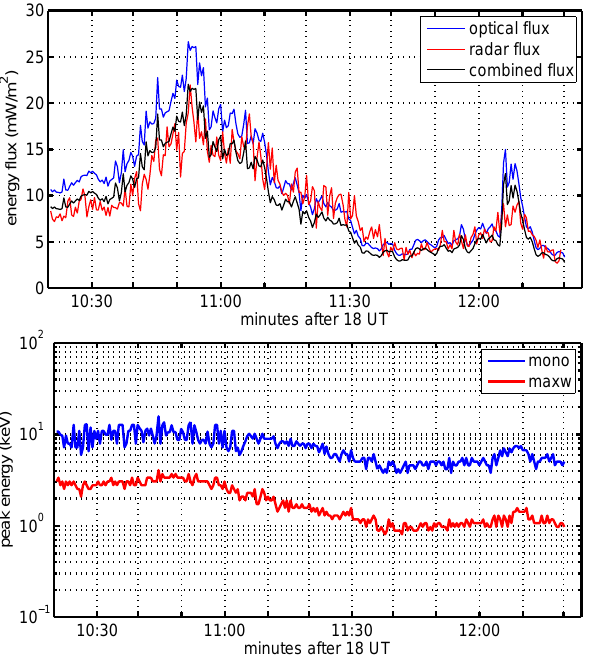
Fig. 5. (a) Total energy flux determined from radar and optical methods. (b) Peak energies of monoenergetic and maxwellian dis- tributions used as input energy spectra for